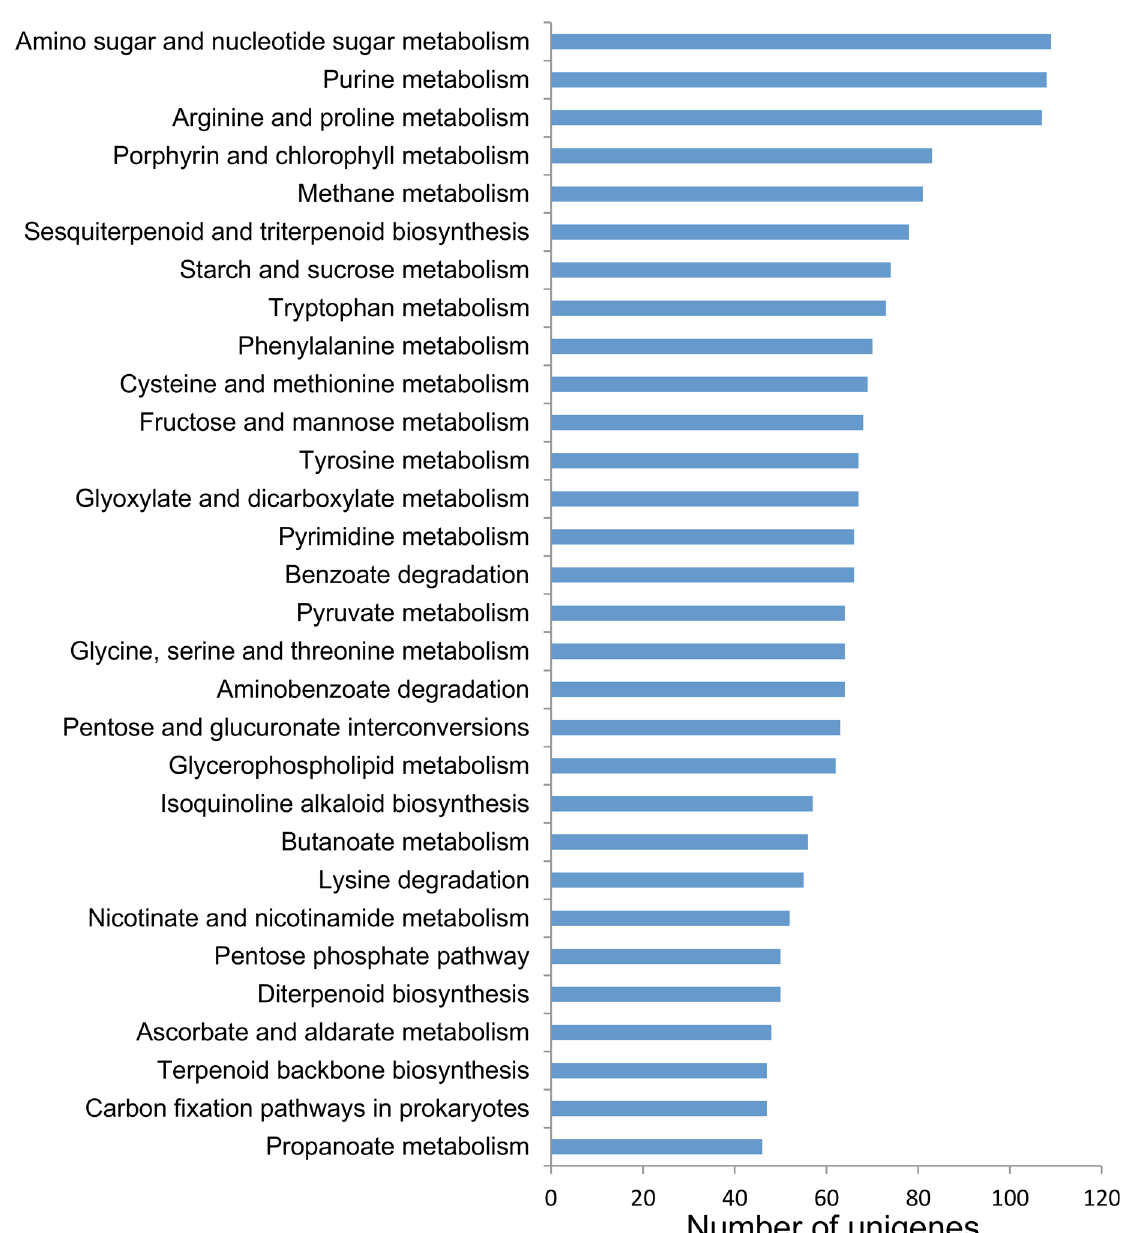
Fig 4. Pathway enrichment analysis of assembled unigenes in red perilla. Annotated unigenes were grouped into 139 KEGG pathways. The top 30 pathways containing unigenes are